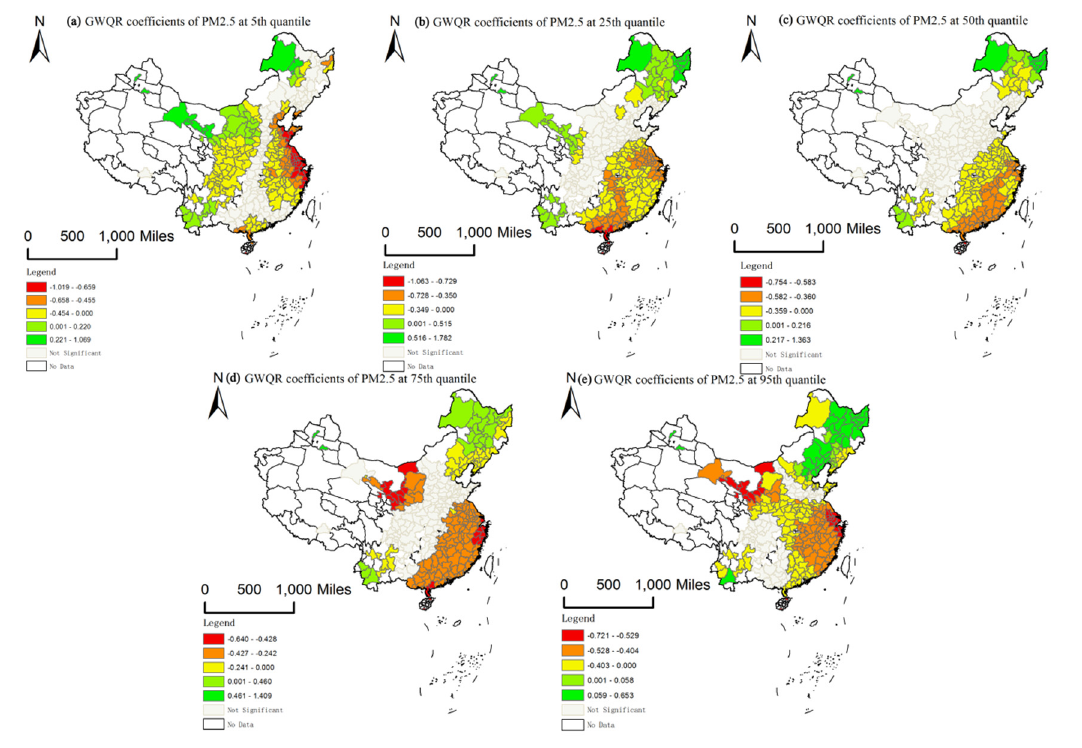
Figure 6. Spatial visualization of significant PM2.5 coefficients of GWQR for 2013. ( a )–( e ) represent the spatial distribution of significant PM2.5 coefficients for the 5th, 25th, 50th, 75th, and 95th quantiles respectively.